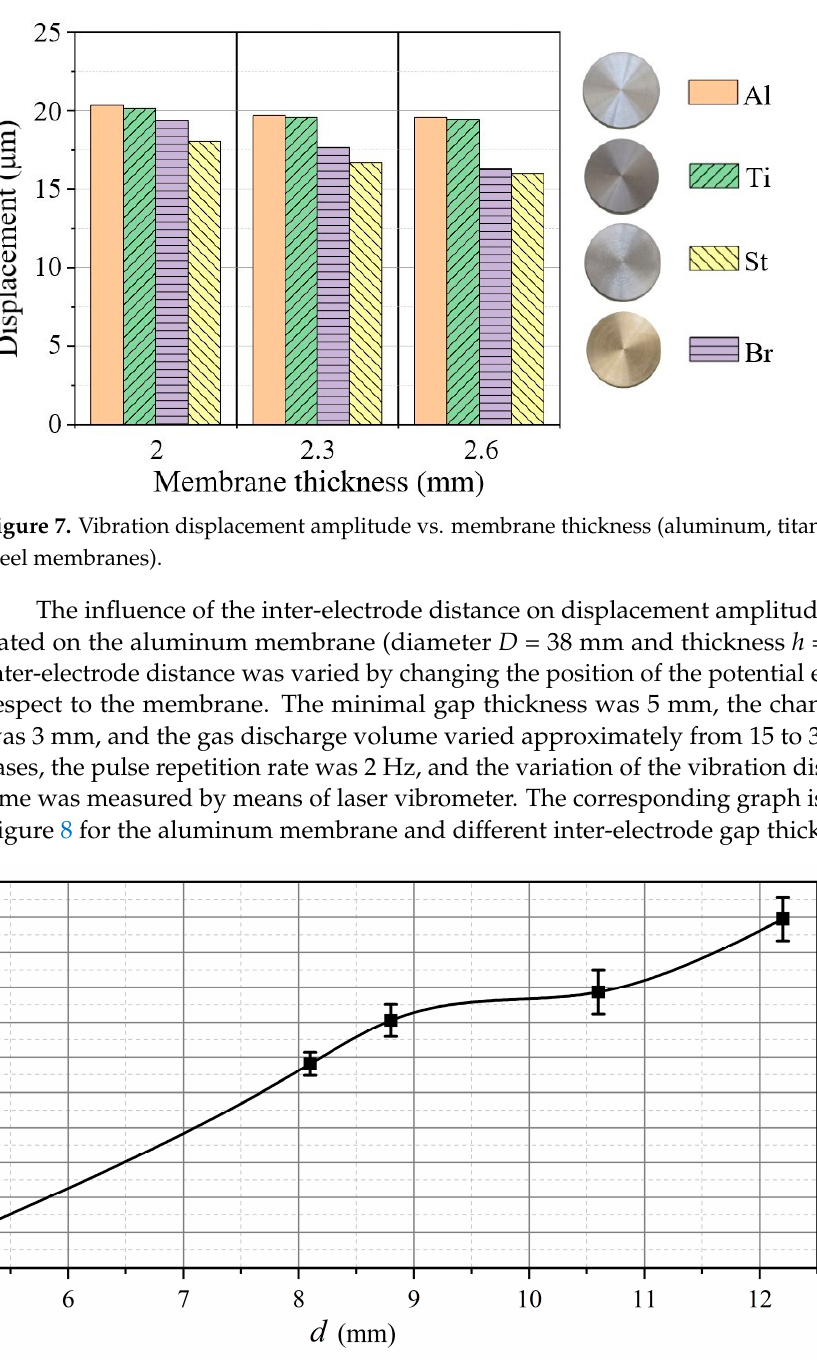
Figure 8. Vibration displacement amplitude vs. inter-electrode gap thickness (membrane thickness 1 mm).